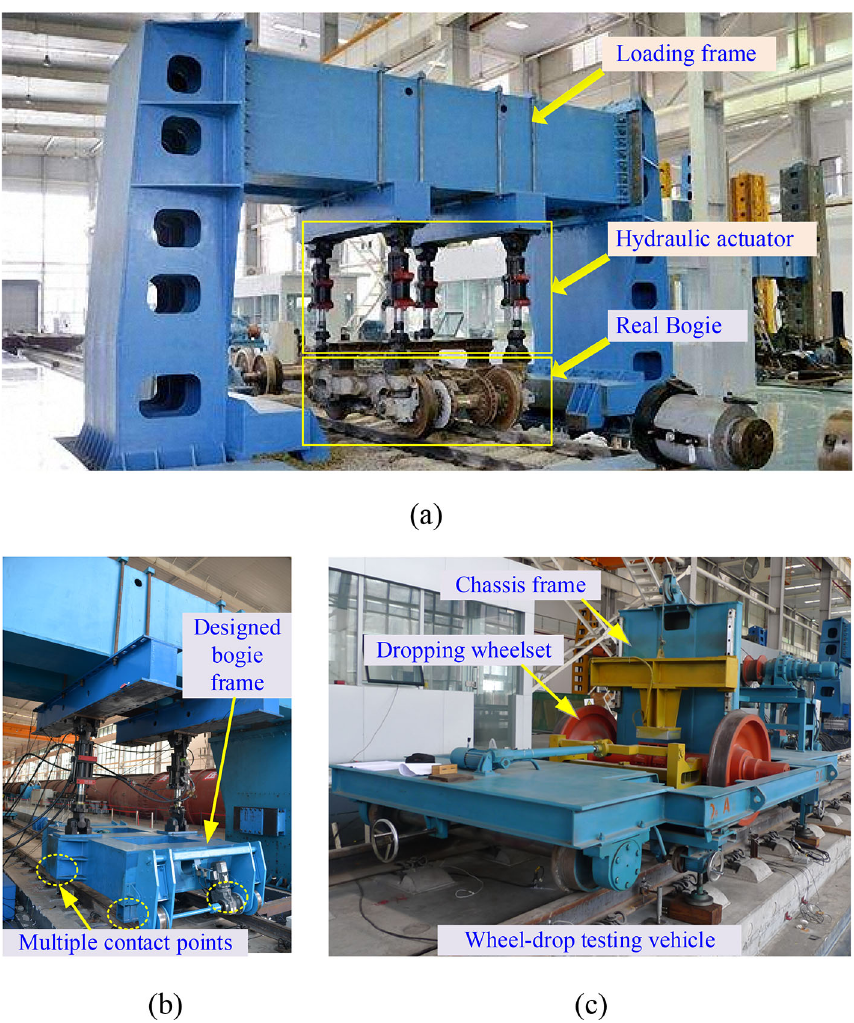
Fig. 13 Loading method used in the test platform: a real bogie loading; b multi-point loading; c impact loading